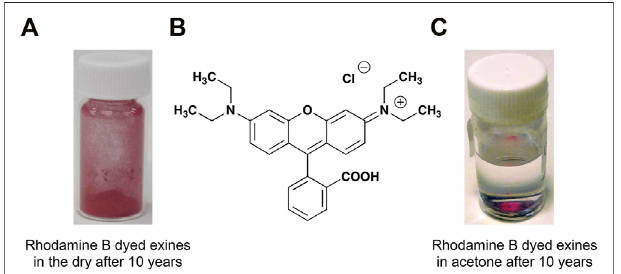
FIGURE 1 | Emptied spores of clubmoss fi lled with rhodamine B (A) , fi lled spores in acetone (C) , and the structure of rhodamine B (B) .